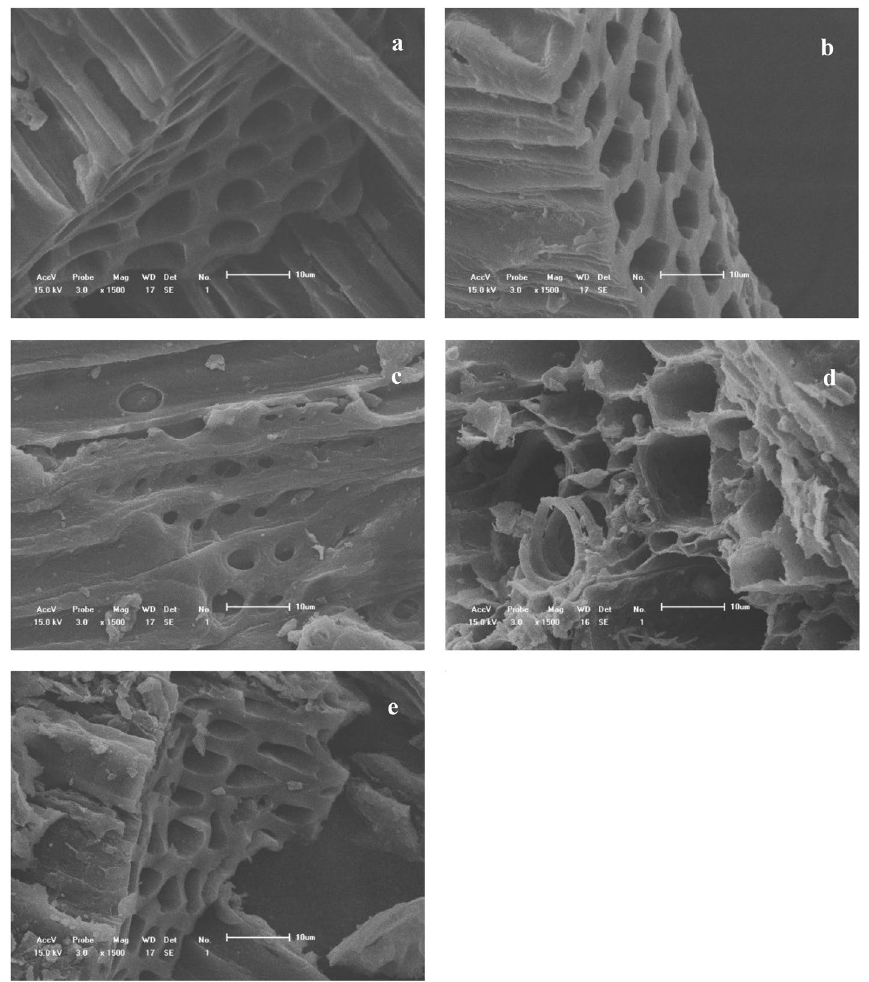
Figure 2. Electron micrographs of different straw biochar. Letter in the picture stands for: ( a ) corn stalk biochar (1500 × magnification); ( b ) Rice straw biochar (1500 × magnification); ( c ) cotton straw